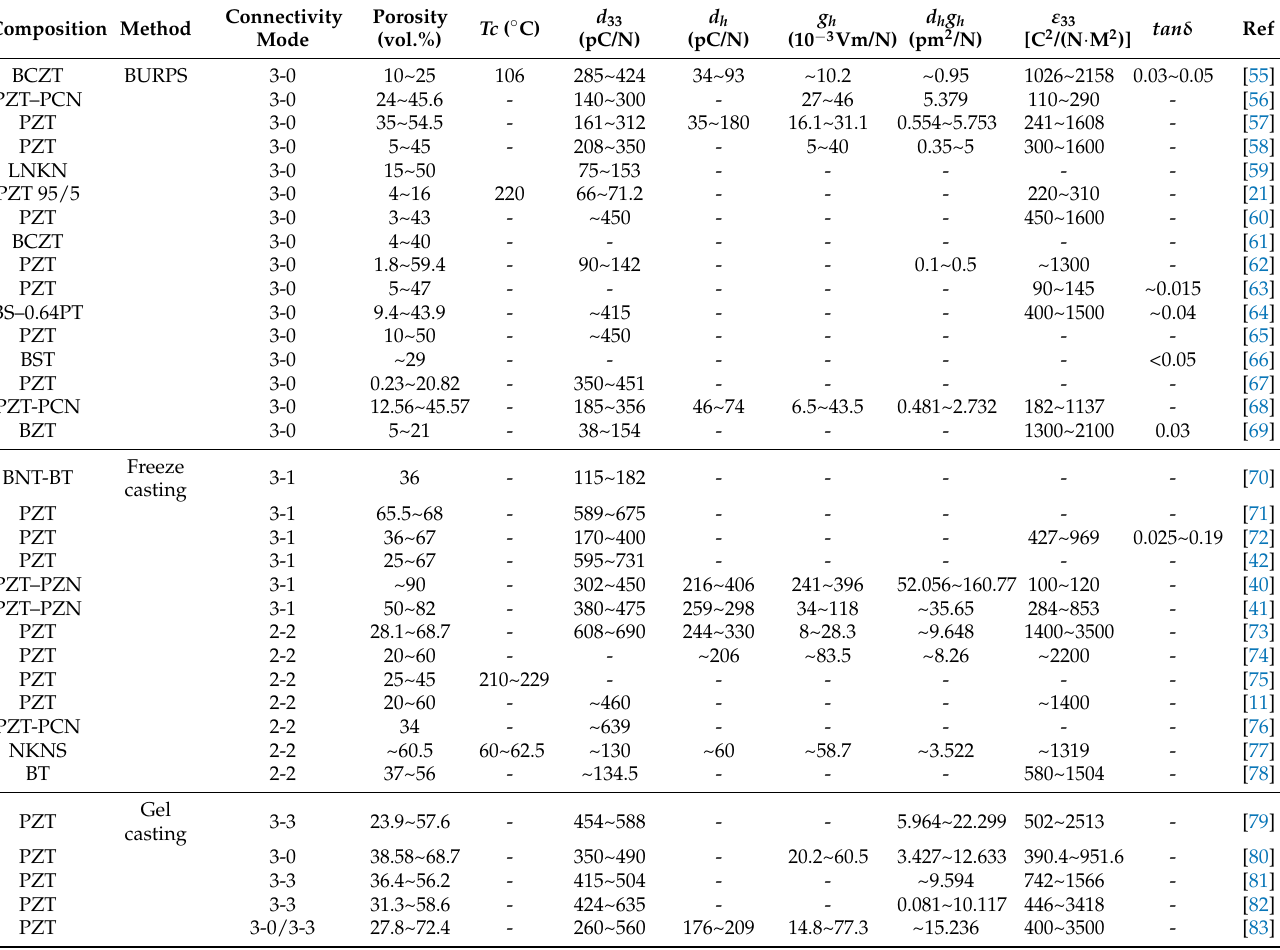
Table 1. Piezoelectric properties of porous ferroelectric